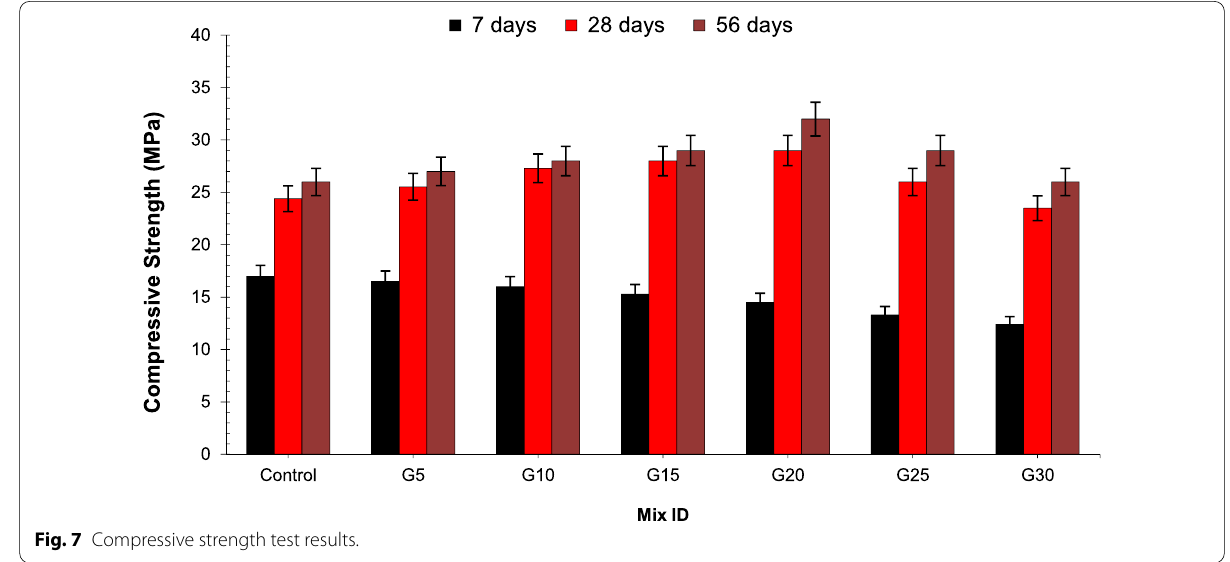
Fig. 7 Compressive strength test results.